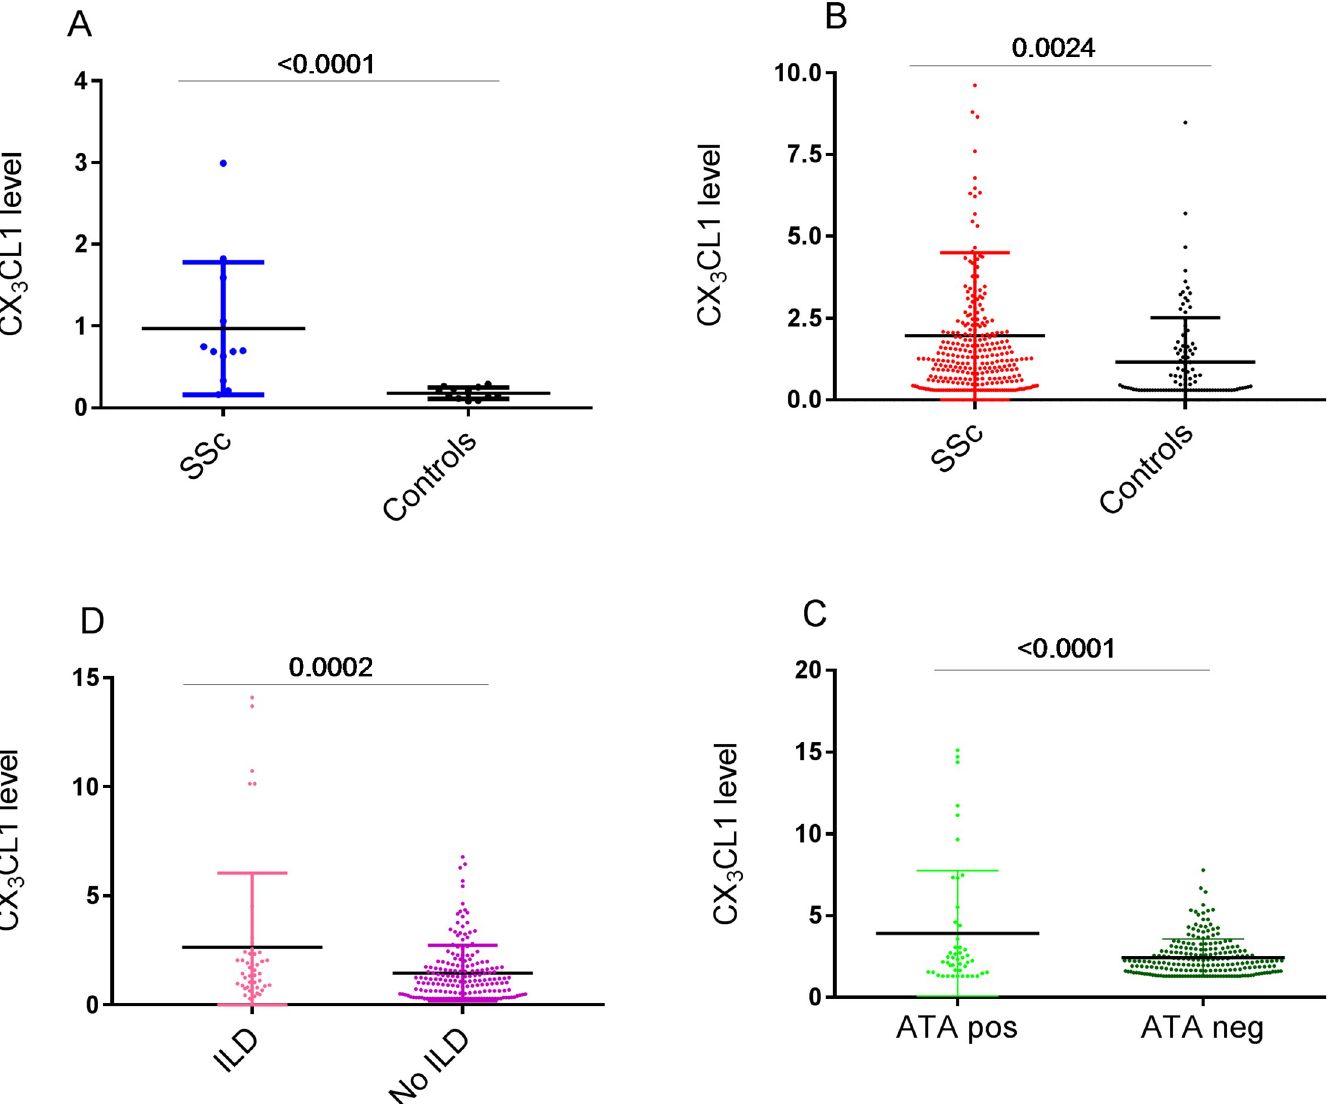
Fig 1. Augmented CX 3 CL1 concentrations in SSc associated ILD. (A) CX 3 CL1 protein concentration in fresh explanted lung tissue homogenates from the UCLA SSc- ILD cohort (n = 12) with and without PH, as compared to healthy lung tissue homogenate control tissue from donor lungs that did not develop any PGD (n = 12). (B) Serum concentrations of CX 3 CL1 from patients with SSc from the OUH cohort (n = 292) as compared to healthy controls without any systemic diseases (n = 100). (C) Serum concentrations of CX 3 CL1 in the OUH SSc cohort from patients with (n = 51) and without (n = 241) SSc-ILD at baseline. (D) Serum concentrations of CX 3 CL1 in the OUH SSc cohort from patients with (n = 47) and without (n = 245) a positive ATA.